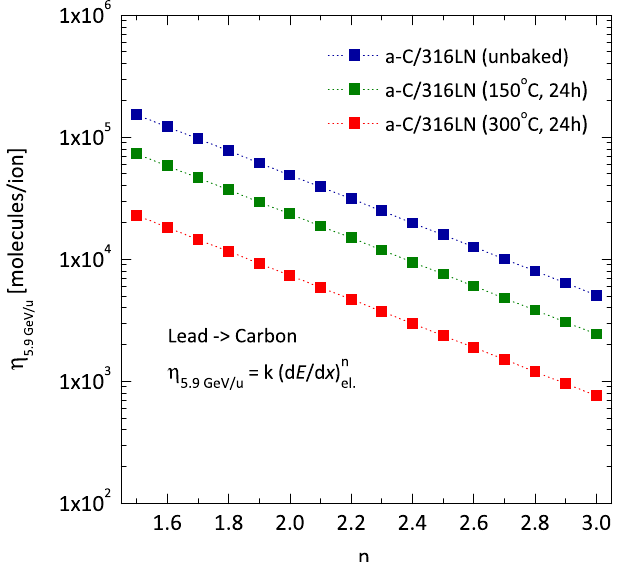
FIG. 9. Extrapolated high-energy lead-ion induced desorption measured at 4 : 2 MeV = u for unbaked and baked yields (cid:1) 5 : 9 GeV = u amorphous carbon films. The three curves show the yield varia- tion as a function of n